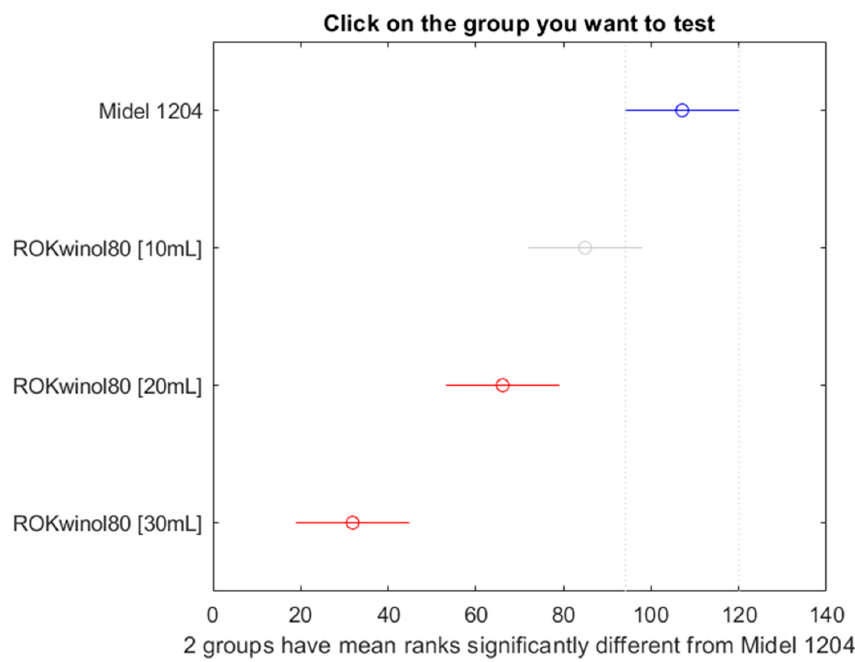
Figure 19. Post hoc Bonferroni test for oil Midel 1204 with different concentrations of surfactant ROKwinol80.